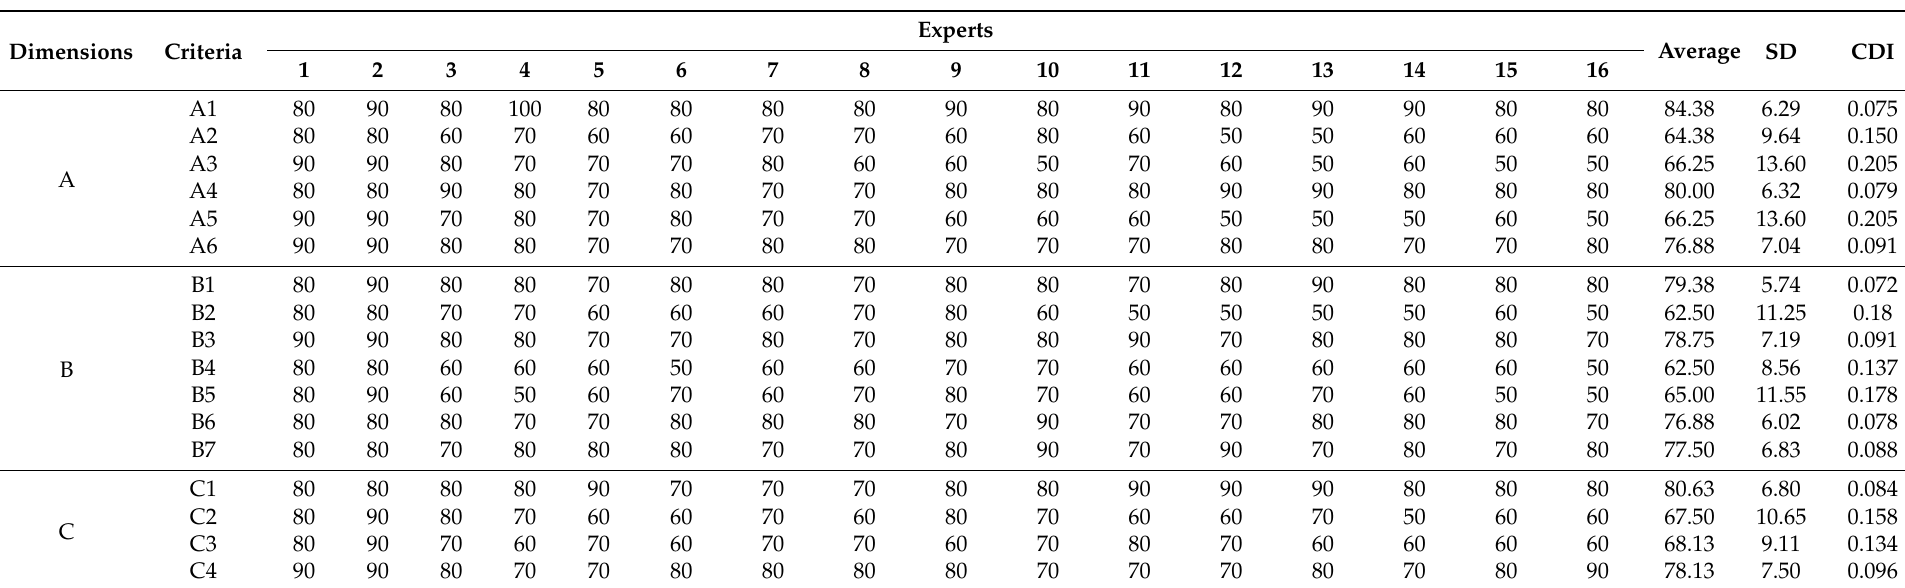
Table 12. First-round Rating on the Necessity of